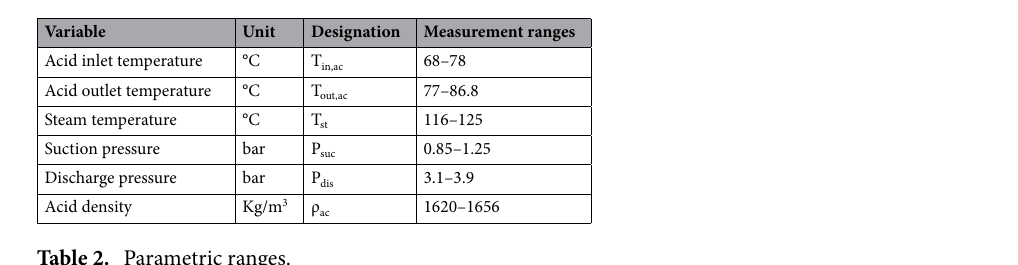
Table 2. Parametric